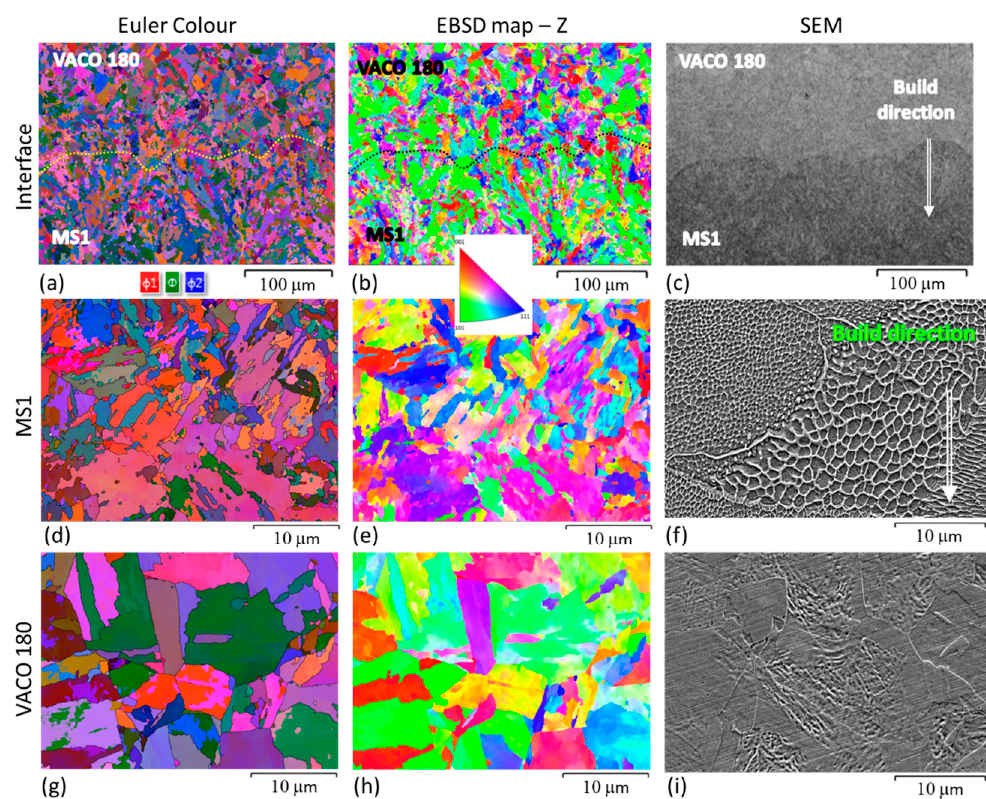
Figure 10. Hybrid part without post-processing heat treatment: Euler maps ( a , d , g ); Inverse pole figures in Z direction (IPF–Z direction) ( b , e , h ); and SEM micrographs ( c , f , i ); VACO 180-MS1 Interface—the interface is marked with a dotted line in the EBSD images ( a , b , c ); additively manufactured MS1 ( d , e , f ); conventionally prepared VACO 180 ( g , h , i ).